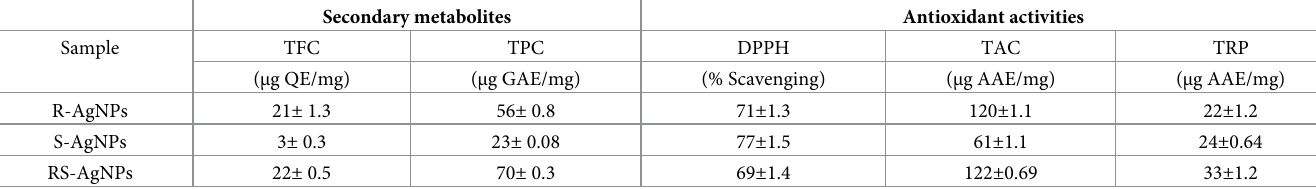
Table 1. Results of antioxidant and phytochemical